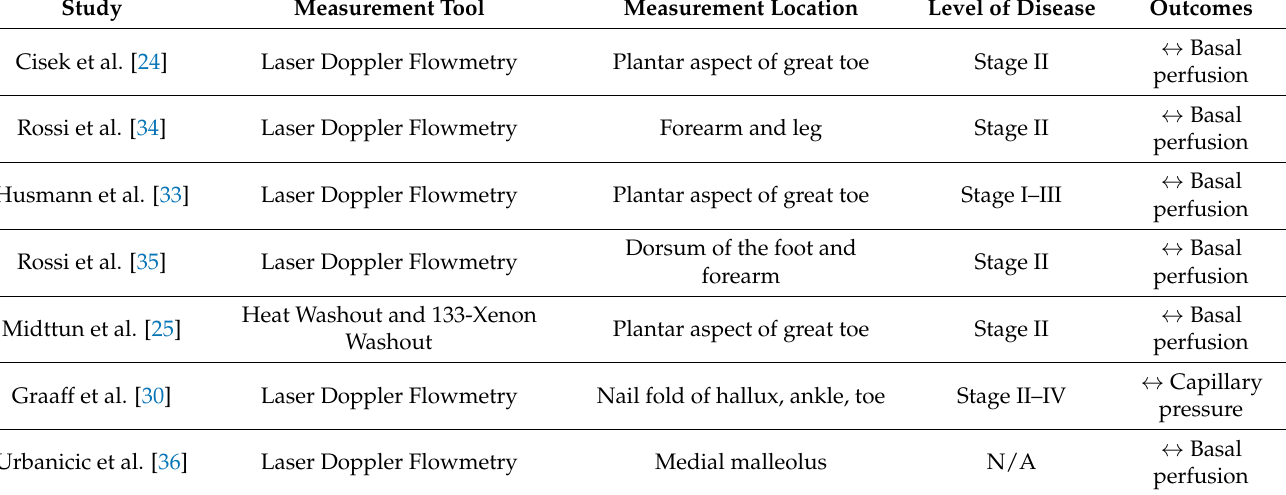
Table 1. Basal cutaneous capillary perfusion and pressure are preserved in non-critical limb ischemia (CLI) peripheral artery disease (PAD) patients compared to controls. Level of Disease is based on the Rutherford and Fontaine classification systems, which classify the progression of PAD into four major categories: Stage I is asymptomatic, Stage II is characterized by intermittent claudication, Stage III is characterized by rest pain, and Stage IV is characterized by tissue loss and ischemic ulcer